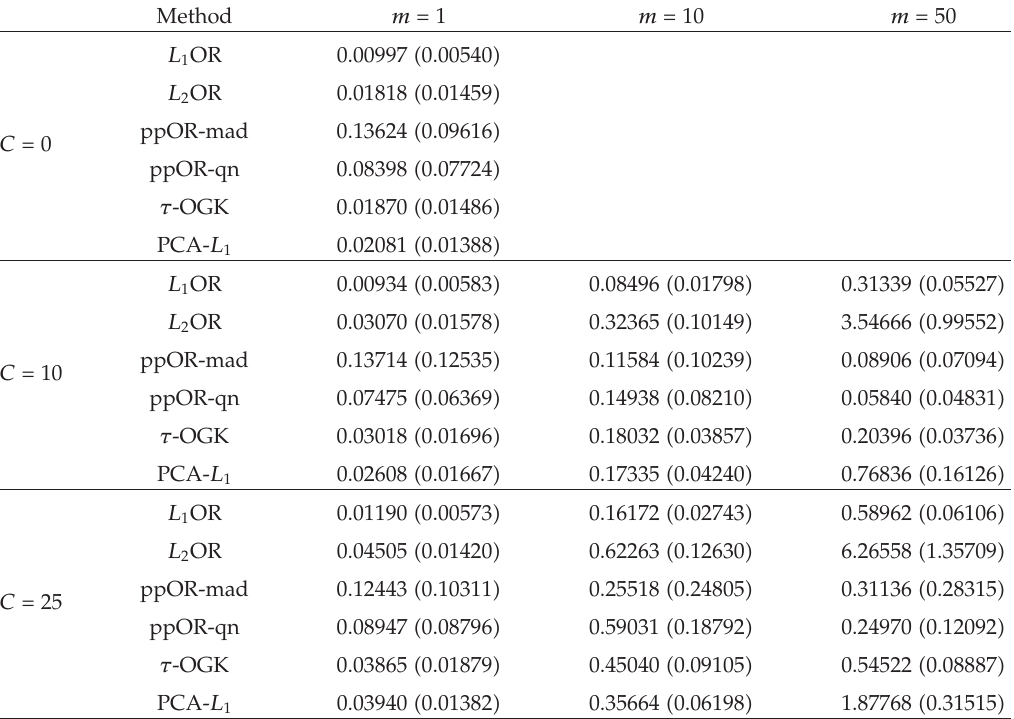
Table 1: Mean (cid:2) standard deviation (cid:3) of D for L 1 OR, L 2 OR, ppOR-mad, ppOR-qn, τ -OGK, and PCA- L 1 with contamination magnitudes m (cid:8) 1, 1010, and 5050 and contamination levels C (cid:8) 0, 10, and